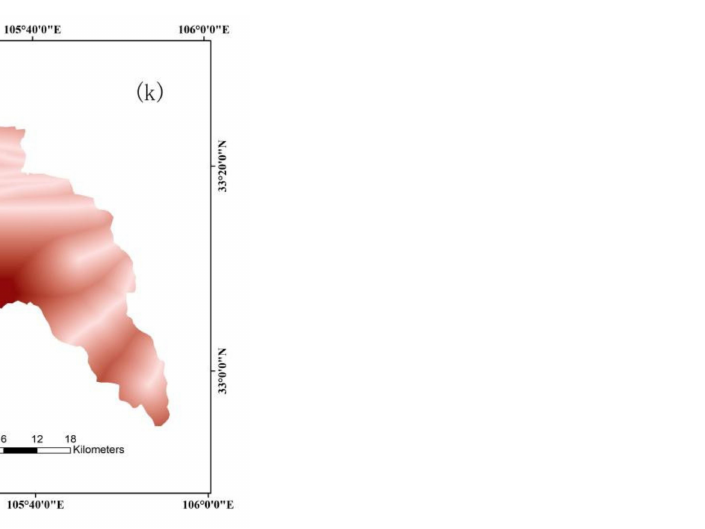
Figure 2. Conditioning factors: ( a ) Altitude. ( b ) Slope. ( c ) Aspect. ( d ) Plane curvature. ( e ) Profile curvature. ( f ) TWI. ( g ) NDVI. ( h ) Lithology. ( i ) Distance to rivers. ( j ) Distance to roads. ( k ) Distance to